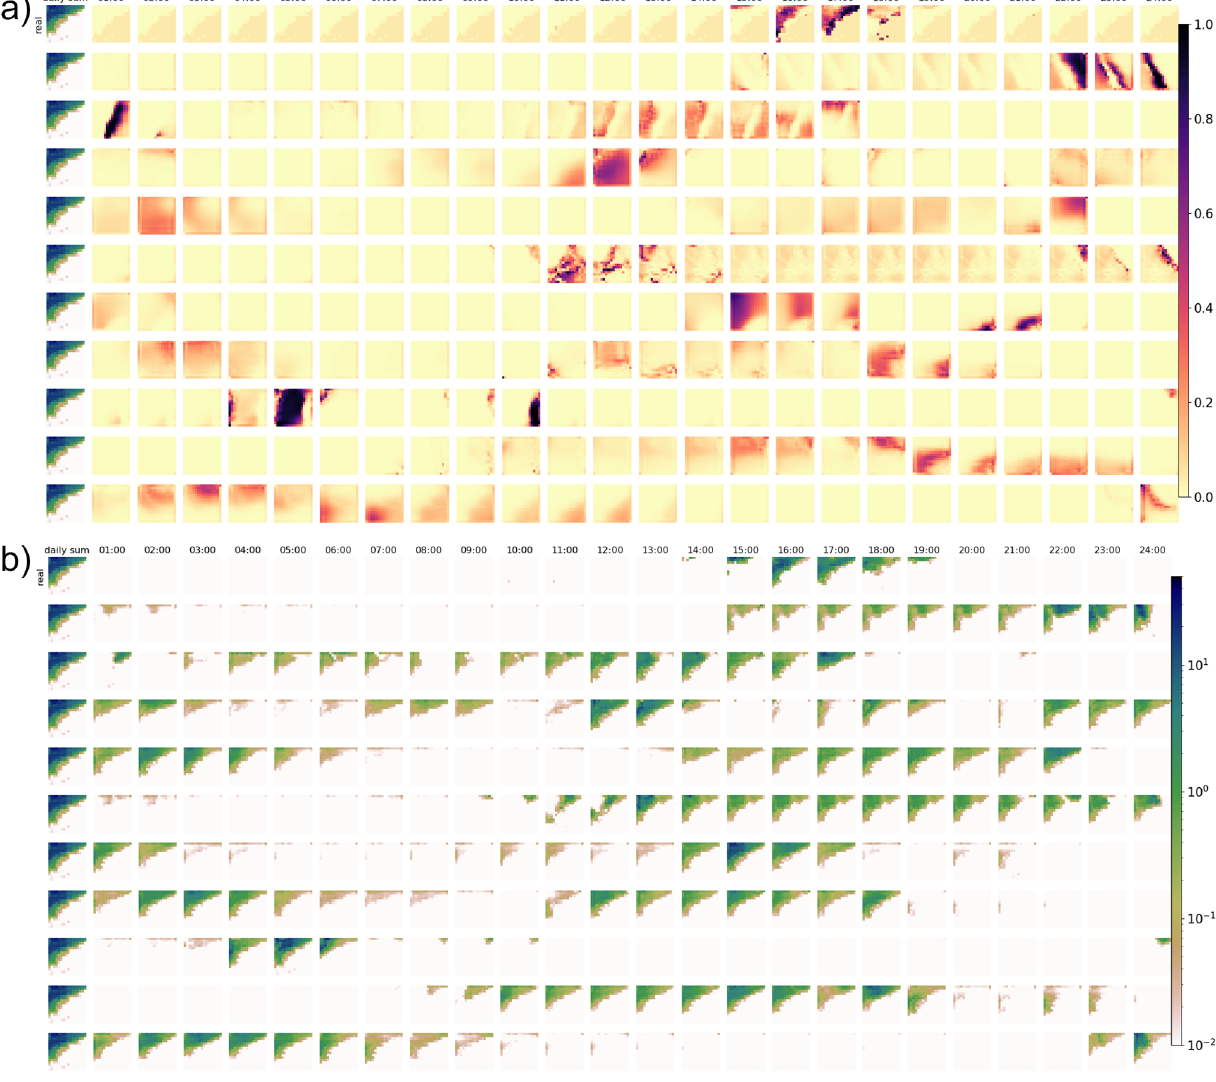
Figure B2. As Fig. 4, but with all hours